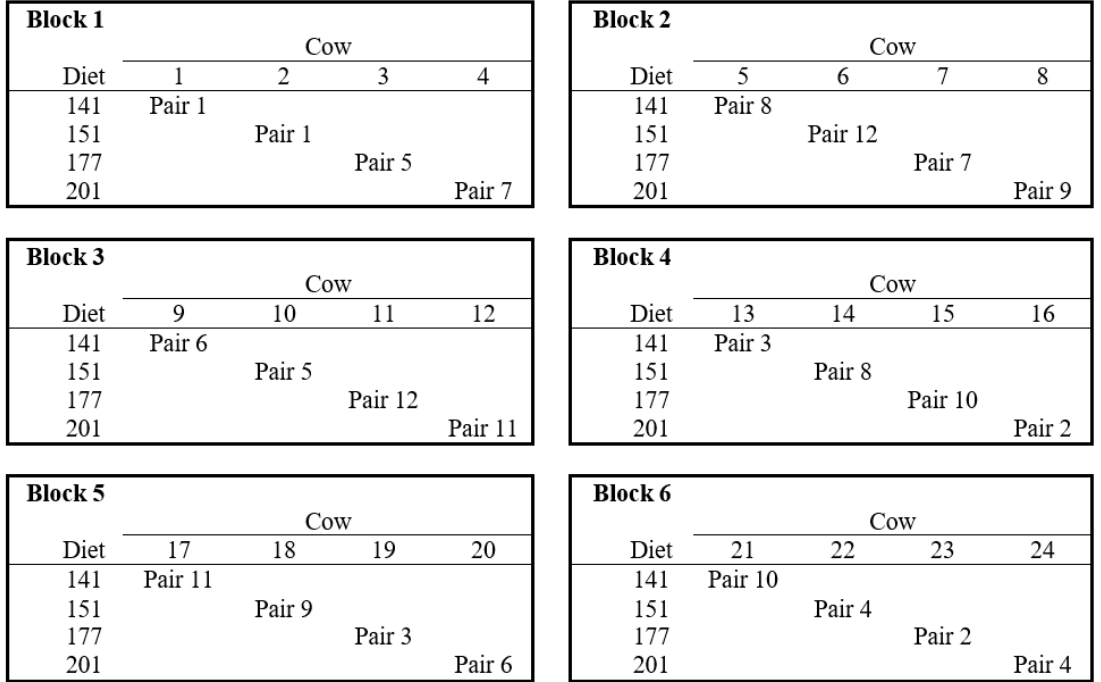
Figure 1. Layout for the six blocks of four cows each (including how they were paired up) and four treatment diets. Pair numbers also refer to the order in which the cows were enrolled in the study. Two cows (i.e., one pair) were enrolled at a time in the order from pair 1 to pair 12, at 3 day intervals.